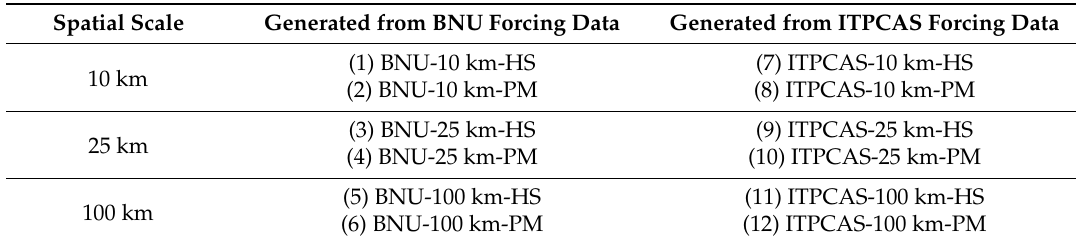
Table 1. PET datasets (2003–2005) used in this study for the purpose of spatial scale effect analysis. Spatial